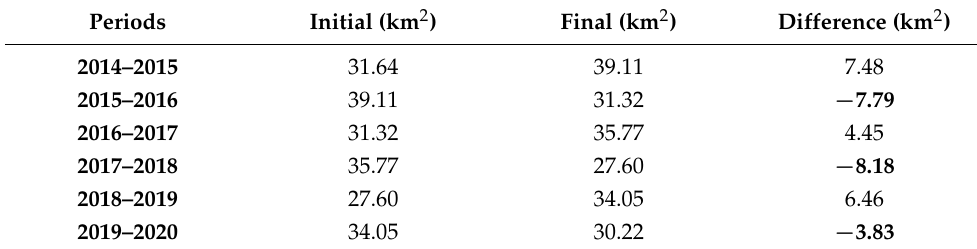
Table 7. Indexes of deforested areas observed (km 2